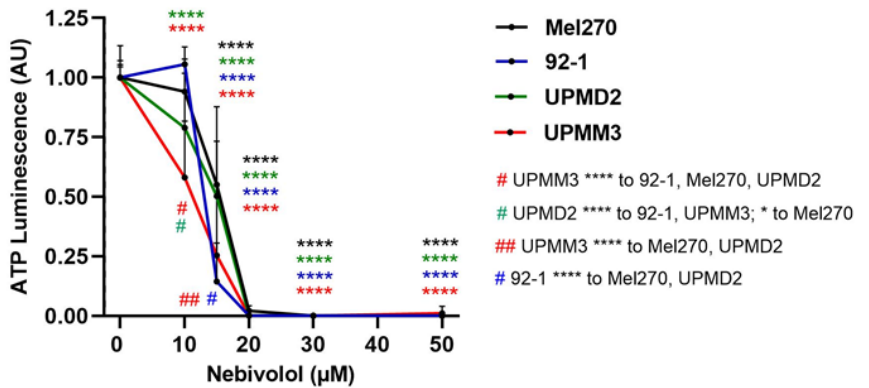
Figure 2. Effects of nebivolol on the viability of various 3D tumor spheroid models. Tumor spheroids were generated from cell lines 92-1 and Mel270 or primary cell lines UPMD2 and UPMM3, and were treated once with nebivolol at the indicated concentrations. Spheroid viability was determined using an ATP luminescence assay after 7 days of incubation with nebivolol. The luminescence of the treated spheroids was normalized to the luminescence of the control spheroids (0 µ M nebivolol), and is given in arbitrary units (AU). Shown are the means ± SD of three independent experiments for each UM tumor spheroid type with n = 6–8 spheroids per condition. Statistical analysis was conducted using two-way ANOVA and Tukey’s multiple comparisons tests. The significance levels of treated spheroids relative to control spheroids (0 µ M nebivolol) are shown in color. Significance levels are indicated at **** p < 0.0001. The significance level of nebivolol-treated spheroids relative to other spheroid types is indicated with # or ## (figure legend bottom right corner * p < 0.05, **** p < 0.0001).